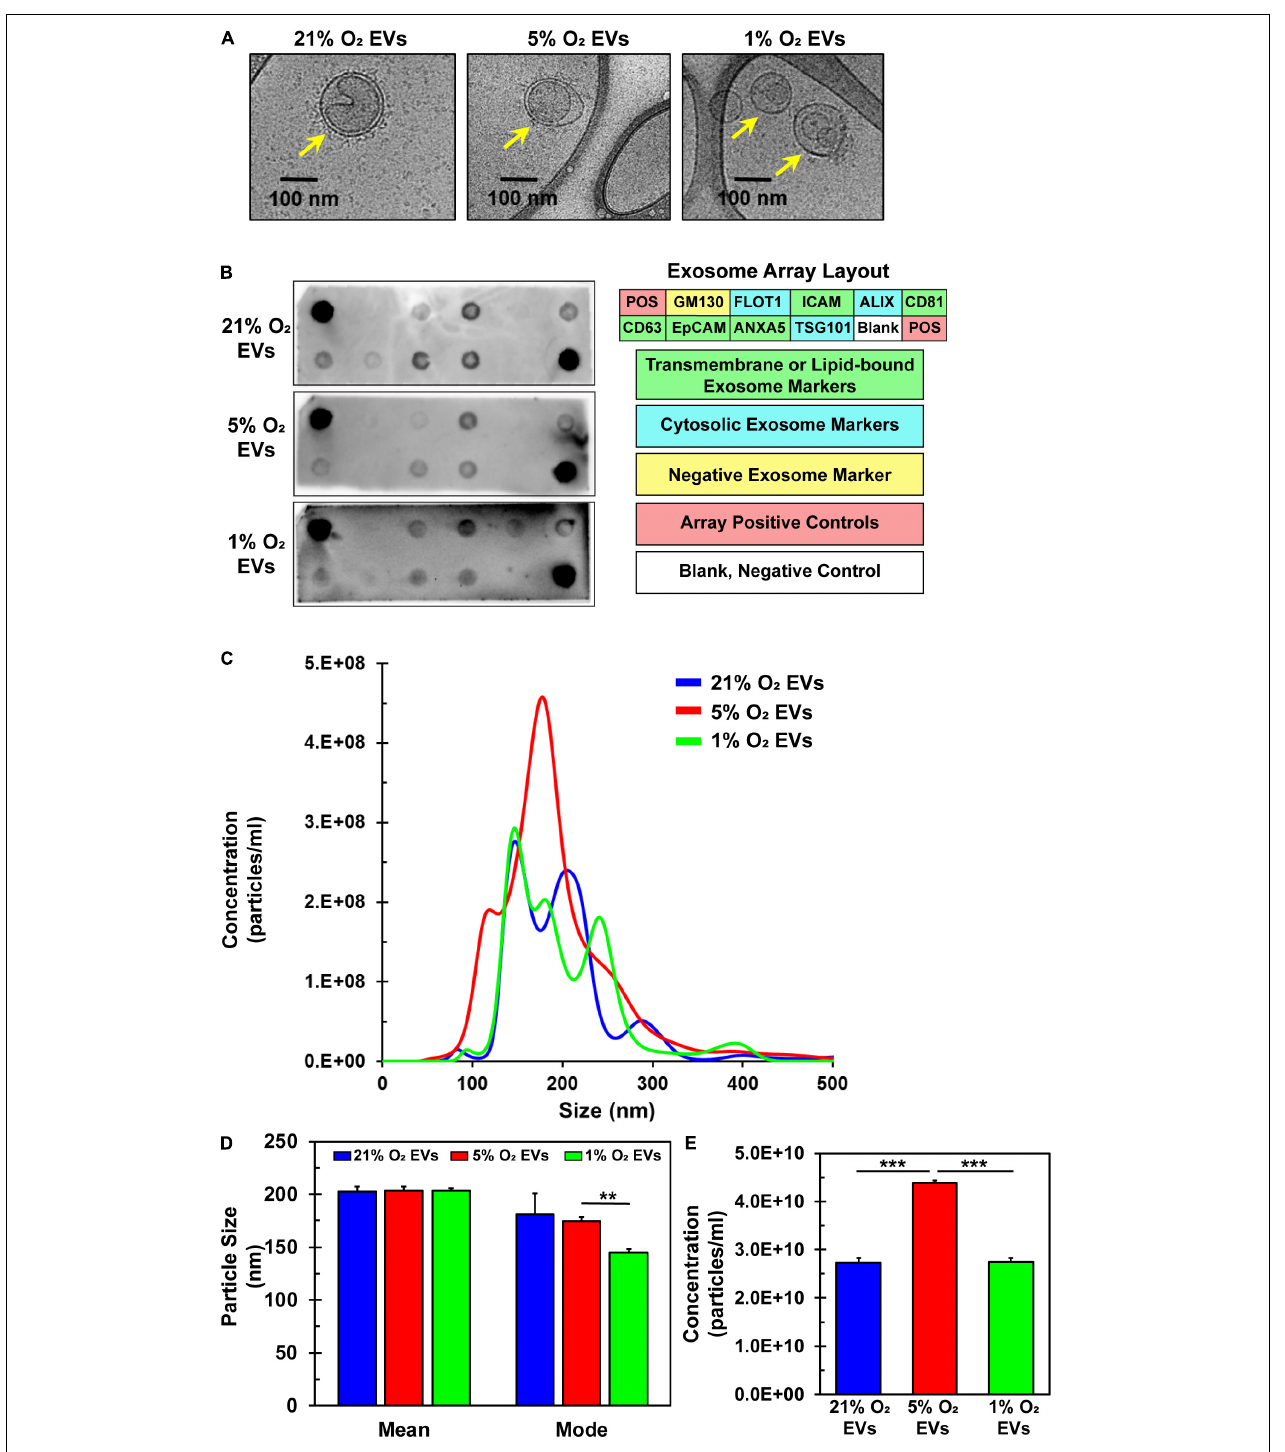
FIGURE 4 | Characterization of EVs derived from hCPCs under varying oxygen microenvironment. hCPCs were cultured under three different oxygen condition (21, 5, and 1% O 2 ) to generate EVs for analysis. (A) Cryo-TEM of isolated EVs shows their characteristic morphology of a round shape with a lipid bilayer (yellow arrows), which was identified under all three conditions. (B) EVs derived from 21, 5, and 1% O 2 hCPCs were analyzed with an exosome antibody array for known exosome markers and a negative exosome marker. The isolated EVs from all three O 2 conditions met the ISEV minimum requirements for identification. (C) NTA of triplicate samples shows the size and concentration distribution of EVs. (D) Mean and mode sizes of isolated EVs were similar and within the accepted range for extracellular vesicles, data is mean ± SD, n = 3. (E) The concentration of EVs isolated from hCPCs cultured under 5% O 2 microenvironment was higher than 21 and 1% O 2 groups, data is mean ± SD, n = 3. ** p < 0.01, *** p < 0.001.